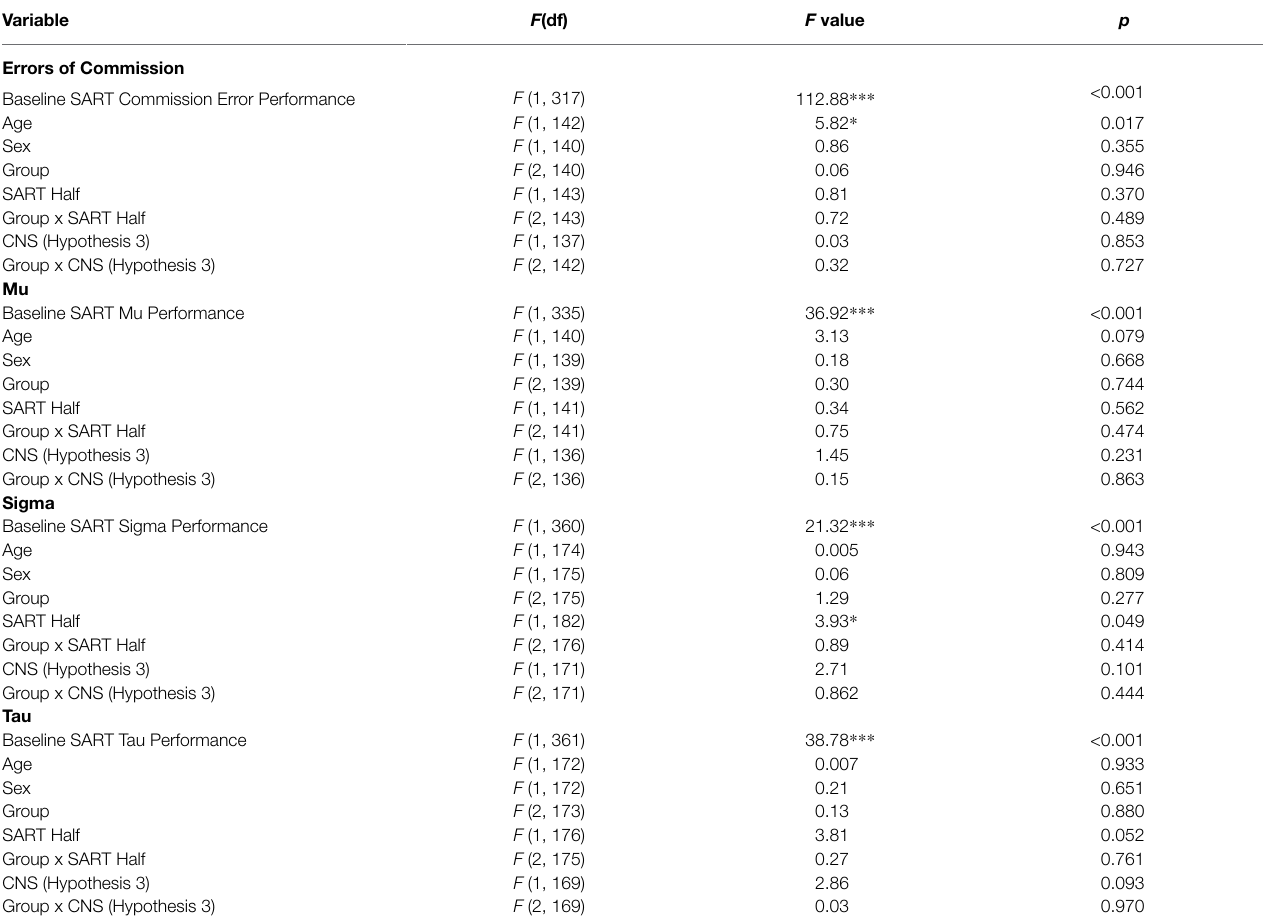
TABLE 6 | Results from the Linear Mixed-Effects Models for Hypotheses 1 and 3 for Study 2. Variable F (df) F